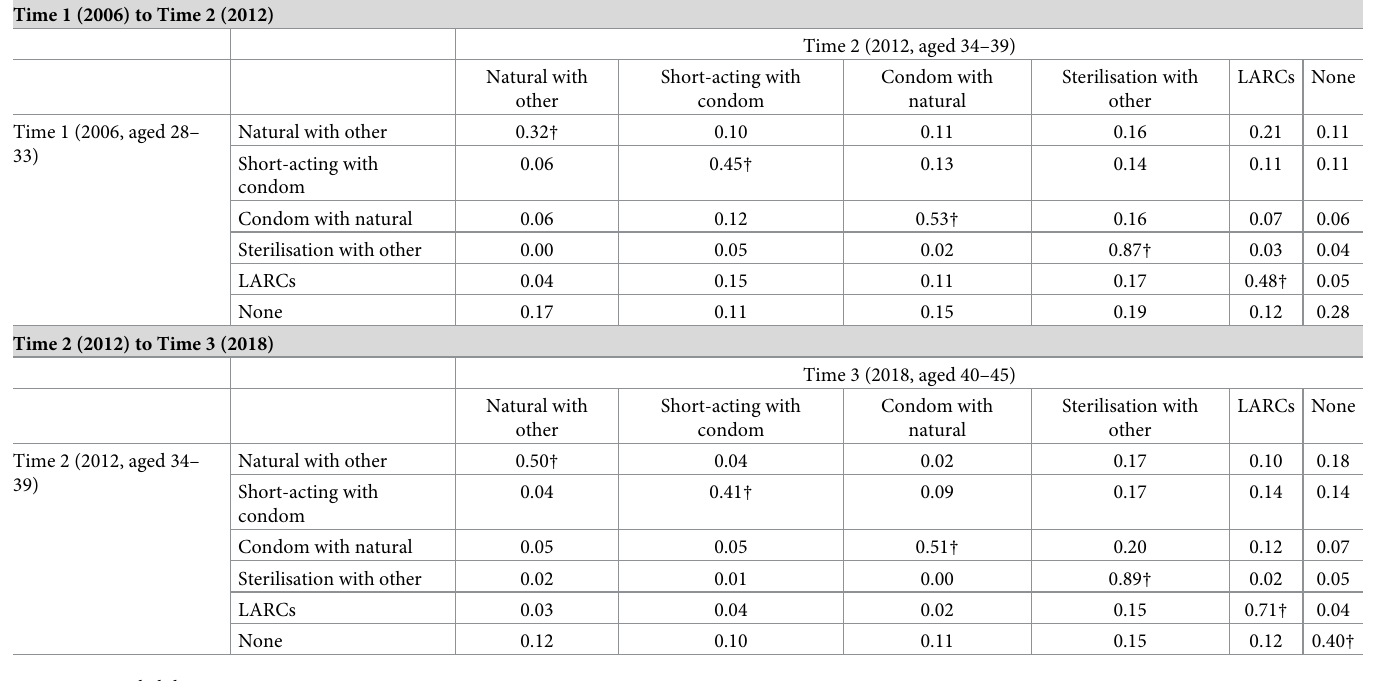
Table 4. Status transition probabilities from Time 1 (2006) to Time 2 (2012), and from Time 2 (2012) to Time 3 (2018). Time 1 (2006) to Time 2